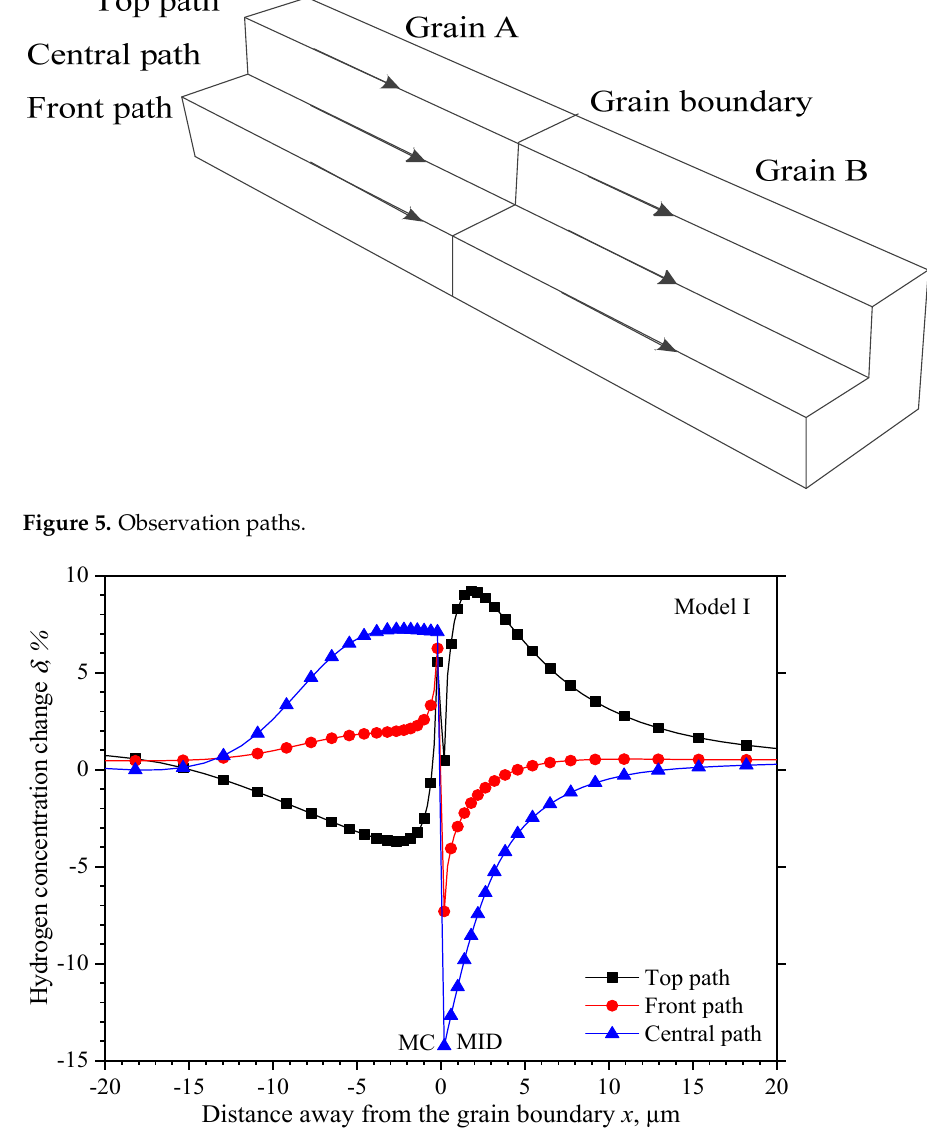
Figure 6. Hydrogen concentration change along observation paths in model I.